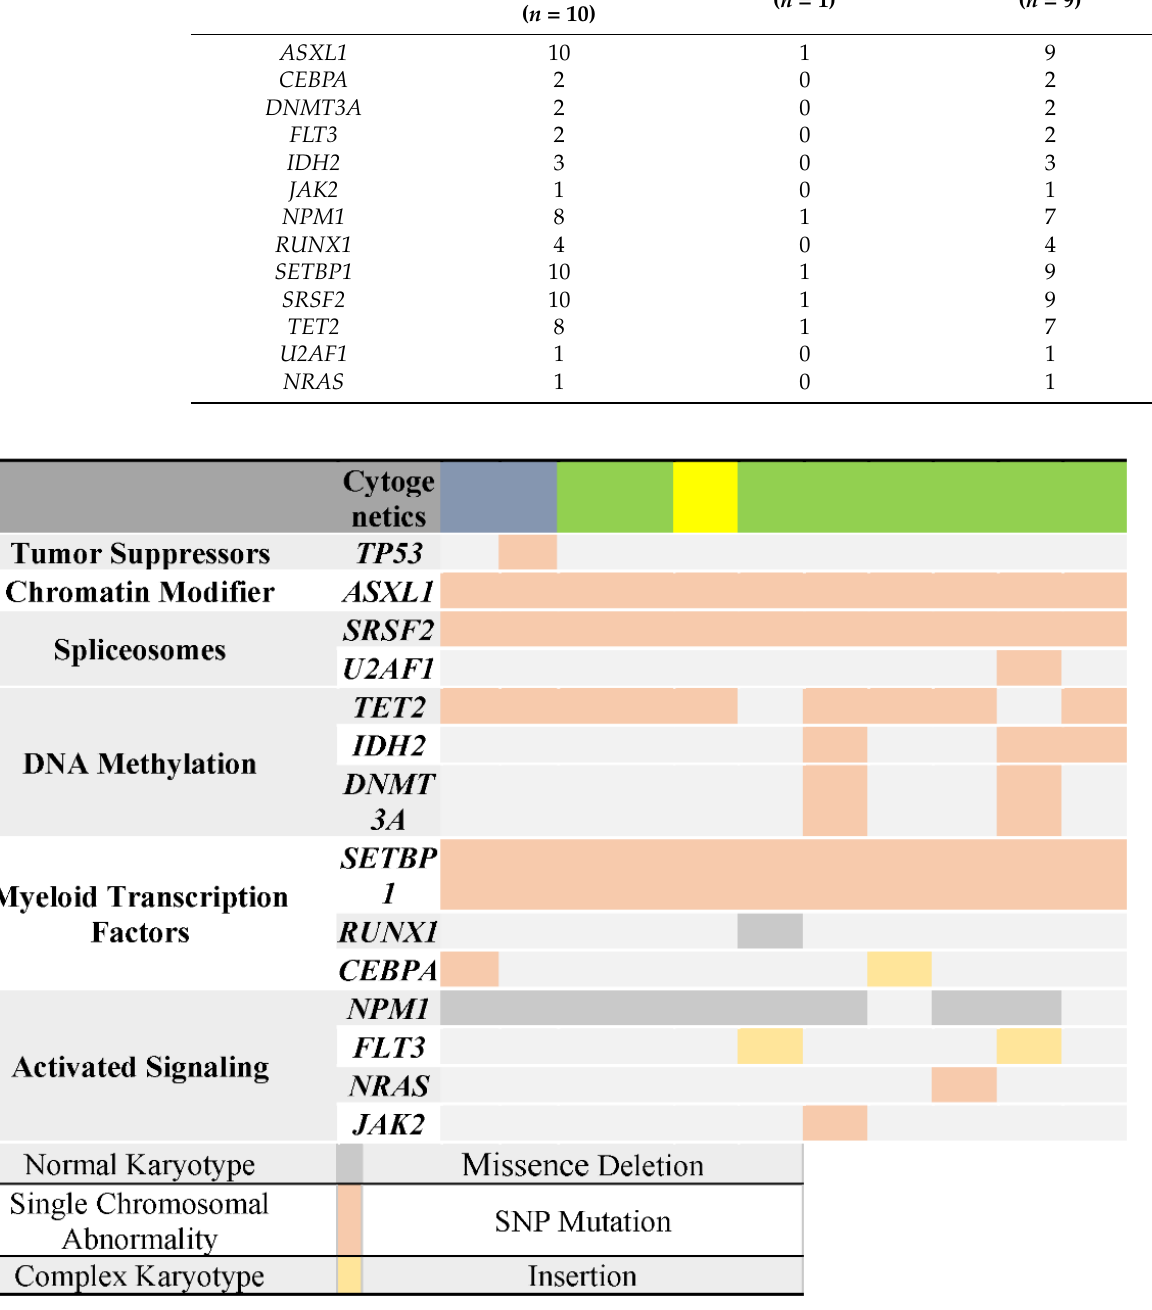
Table 5. Distribution Pattern of Coexisting Mutations in Patients with and without TP53 Mutations. Total No. of Gene